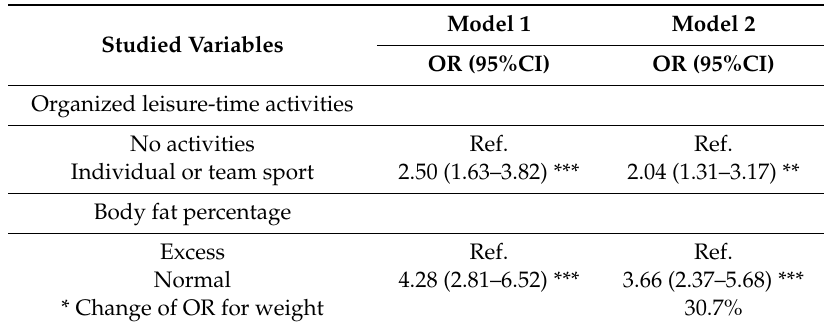
Table 4. The association of organized leisure-time activities with self-rated health, adjusted for age and gender, and additionally adjusted for body fat percentage from logistic regression models (odds ratios—OR / 95% confidence